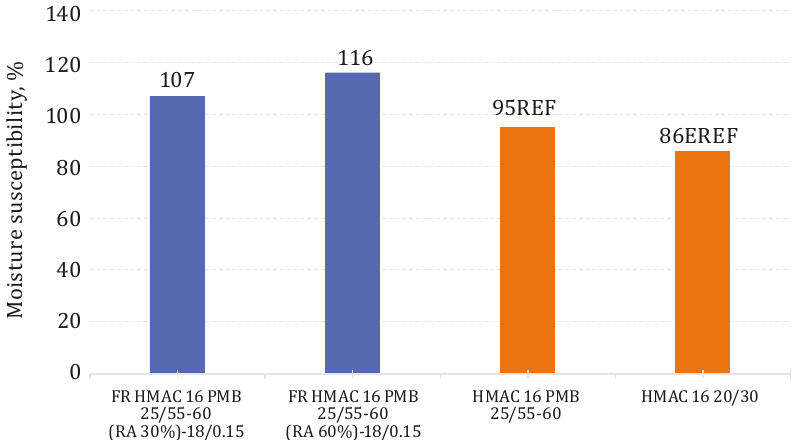
Figure 5. Moisture susceptibility results for the base